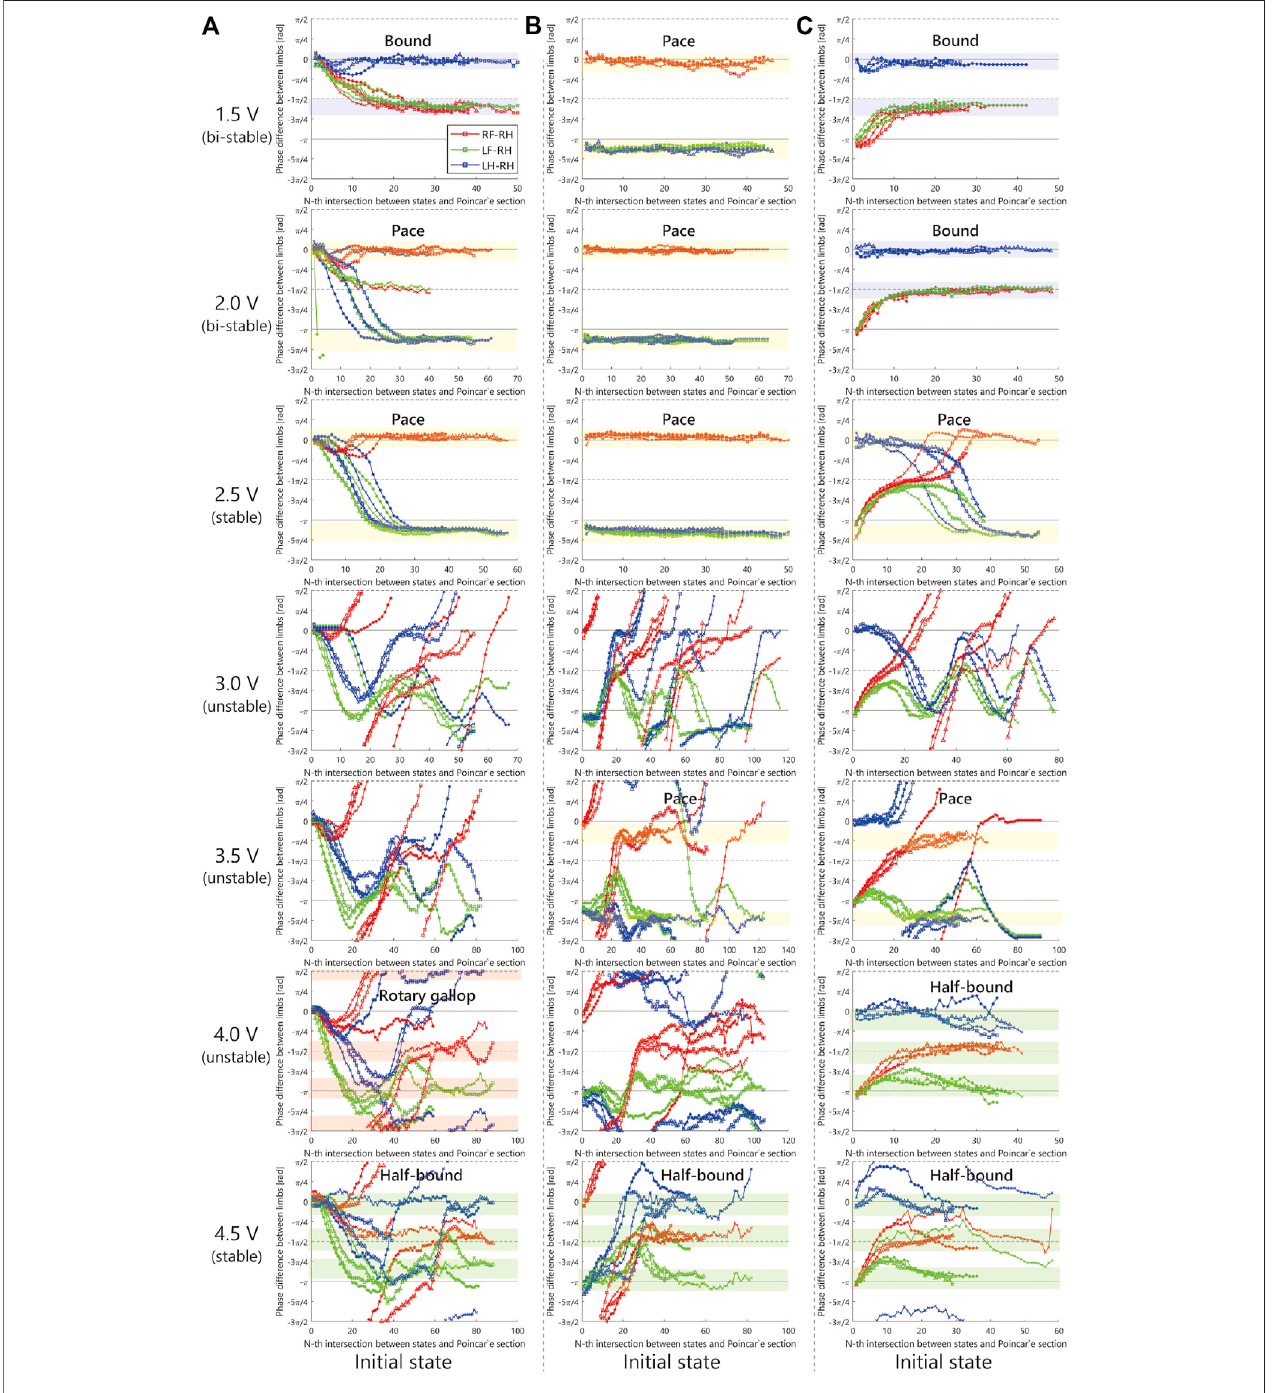
FIGURE 8 | Experimental